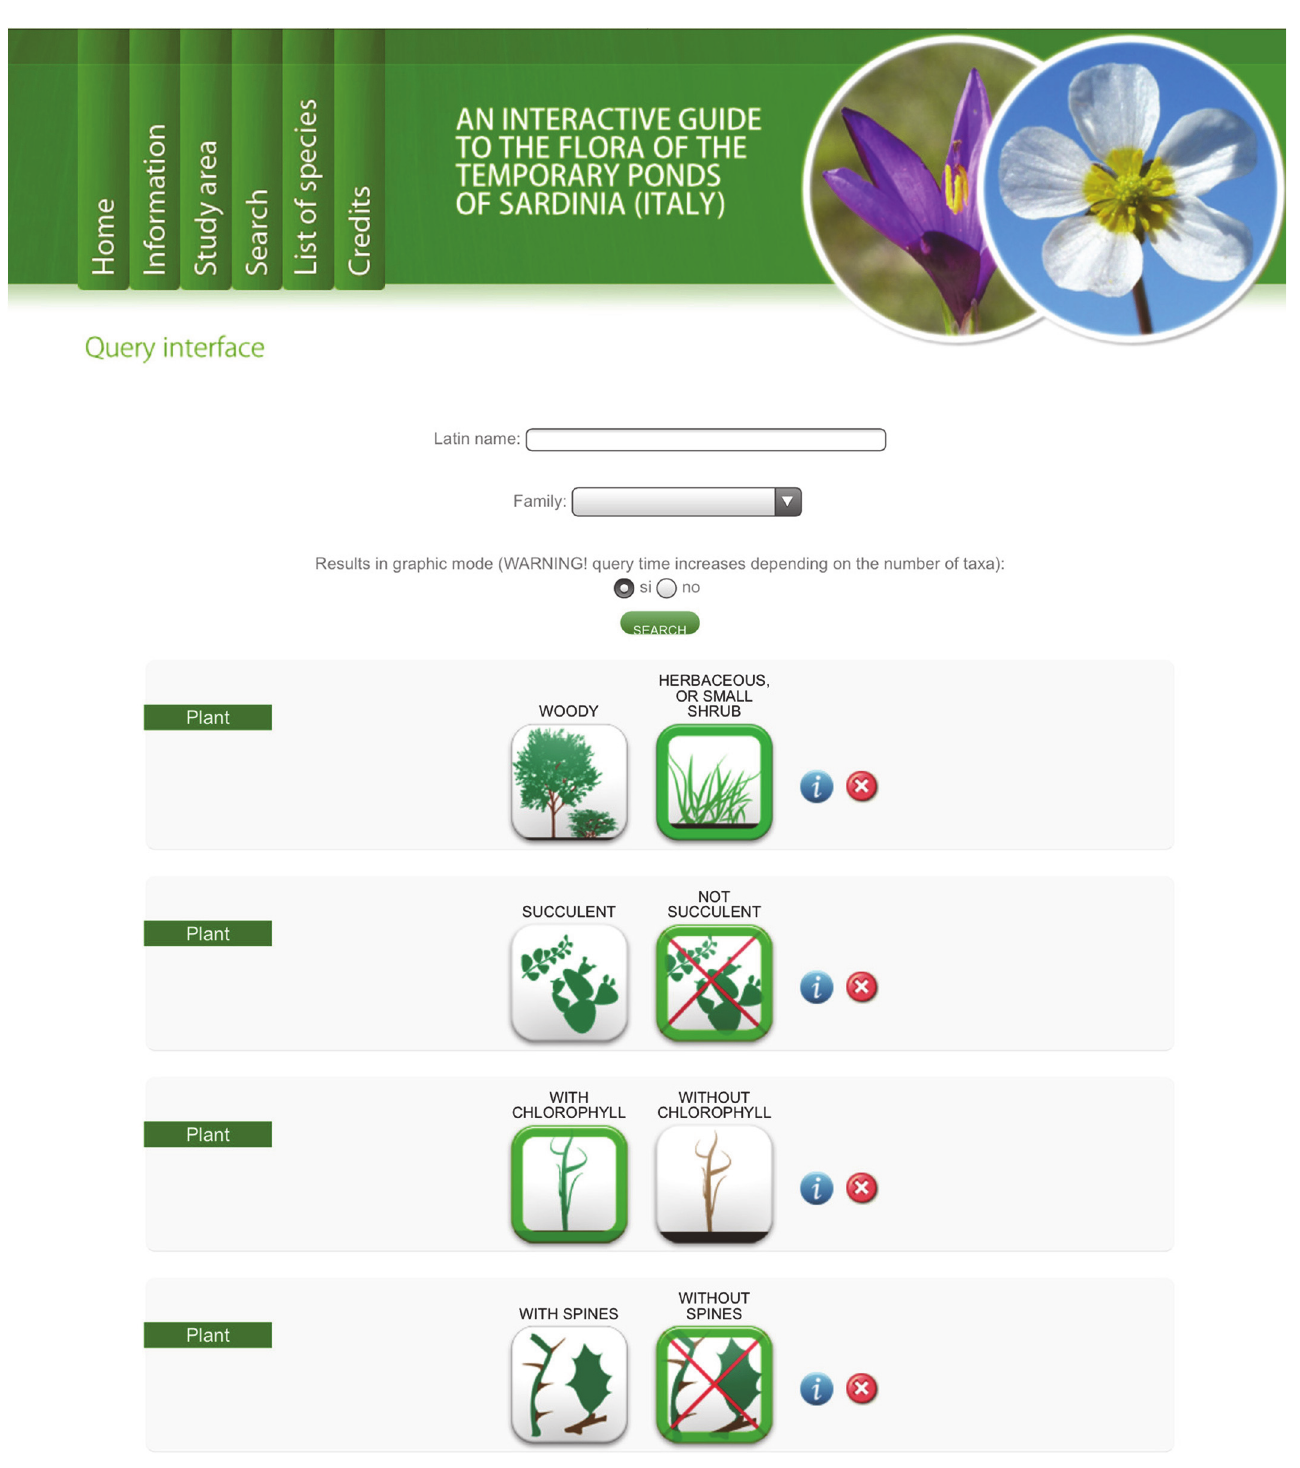
Fig 4. Multi-entry interface . Users can query the database by taxon name, family, and/or by a combination of several easily observable morphological characters. Each character state is displayed by icons, which remain highlighted when clicked.